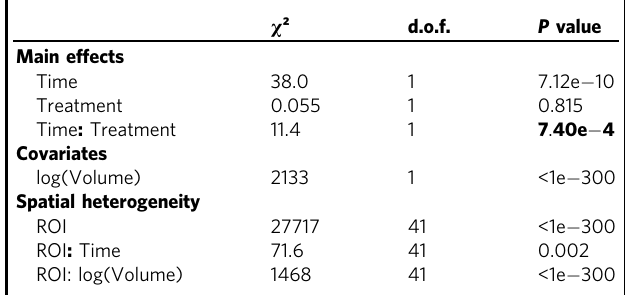
Table. 1 Effect of time (T1 before and T2 after randomization) and treatment (placebo or alteplase) on global score of structural disconnection factoring in the effect of potential spatial heterogeneity in investigated brain areas. Shown is an ANOVA table for the linear-mixed effects model log(ChaCo + ) ~ time × treatment + ROI × (time + log(volume)) + (1|subject), where the last term represents a random intercept for each subject. Two-sided P values are calculated from type II Wald χ 2 tests, as implemented in the R package car 25 .